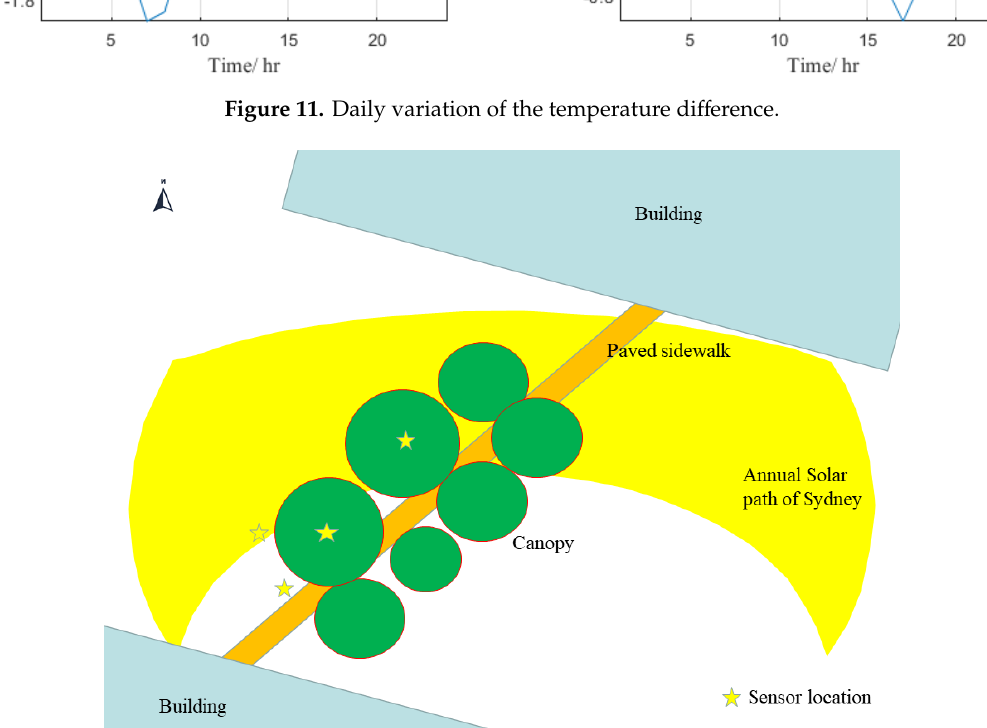
Figure 12. Canopy temperature sensor location.